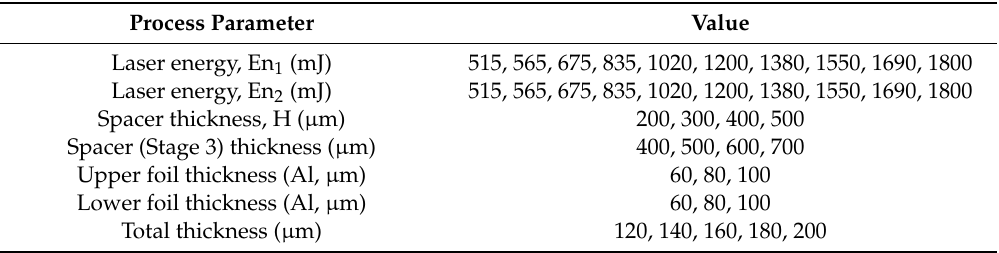
Table 8. Experimental process